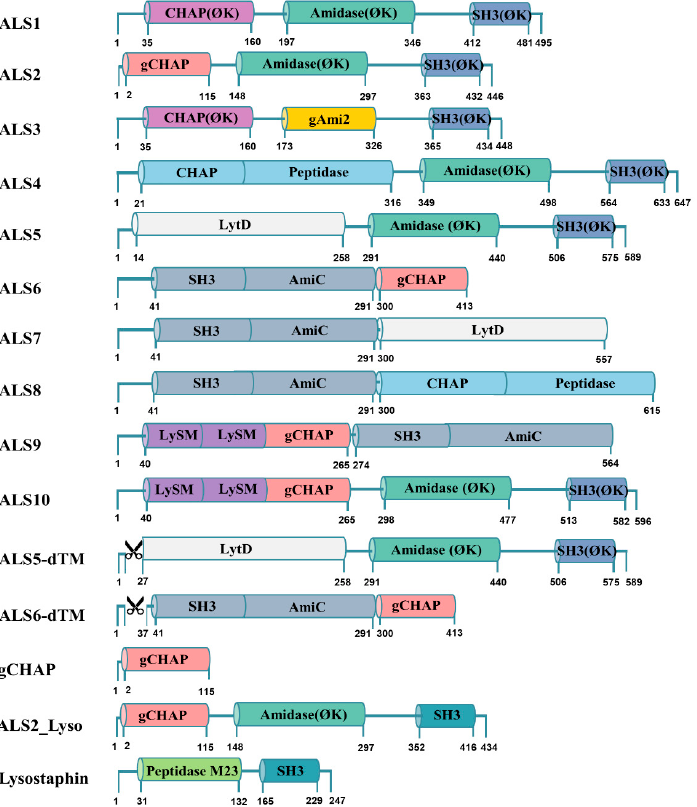
Figure 1. Construction of chimeric lysins. Colors that are common indicate the same domain. The number under the domain indicates the position of the amino acid of the chimeric lysin.